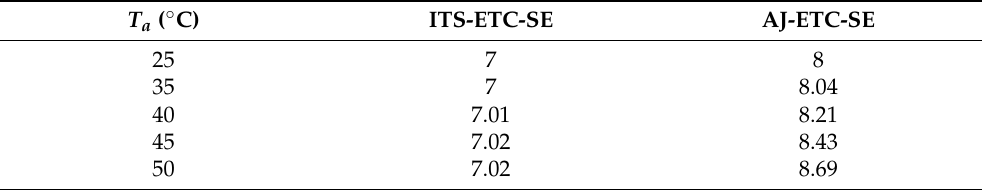
Table 6. Iteration numbers of different algorithms under different ambient temperatures.